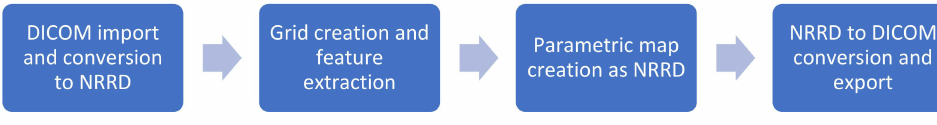
Figure 1. Summarized workflow of the program up to the final parametric